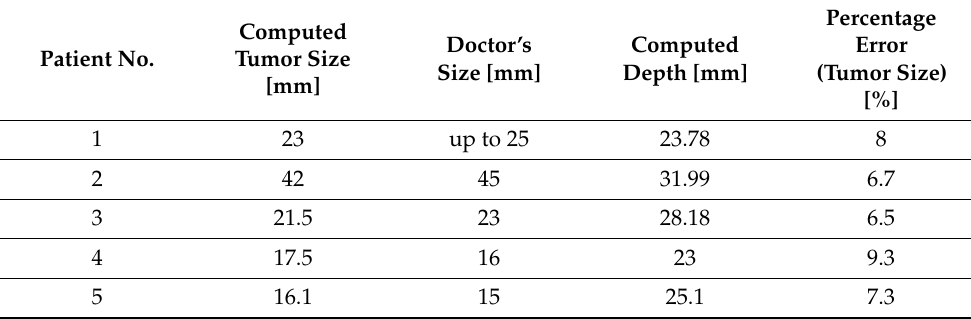
Table 12. Estimated tumor depth and diameter compared with the doctor’s